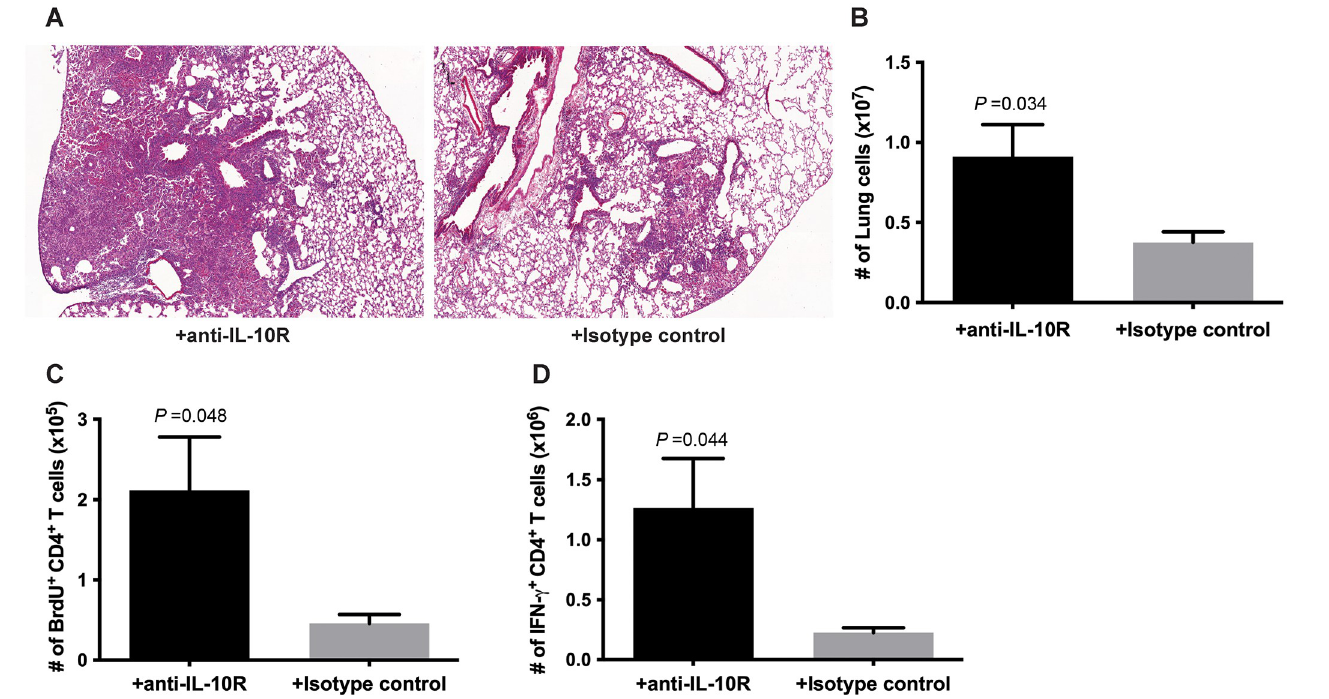
Fig 6. IL-10R blockade reverses the inflammation and diminished CD4 + T cell response phenotypes observed in the lungs of B cell-depleted C57BL/6 mice during chronic M . tuberculosis infection. C57BL/6 mice were depleted for B cells via administration of 5D2 beginning 2 days prior to infection with a low dose (100 CFU) of M . tuberculosis Erdman delivered by aerosol. B cell depletion was maintained for the duration of the experiment. At 3 months after the infection, IL-10R blockade was initiated using the anti-mouse IL-10R antibody clone 1B1.3A. The control group received non-specific rat IgG. The IL-10R blockade was continued for two months. At five months post-infection (2 months after initiation of IL-10R blockade), mice were sacrificed and analyzed for the levels of inflammation in the lungs, as assessed by histological examination (A) and enumeration of total lung cells (B), CD4 + T cells proliferation via BrdU labeling (C), and Th1 response (D). Data shown are representation of two experiments. Three to four mice were analyzed per group. Data depicted in (B), (C), and (D) denote mean ± SEM.